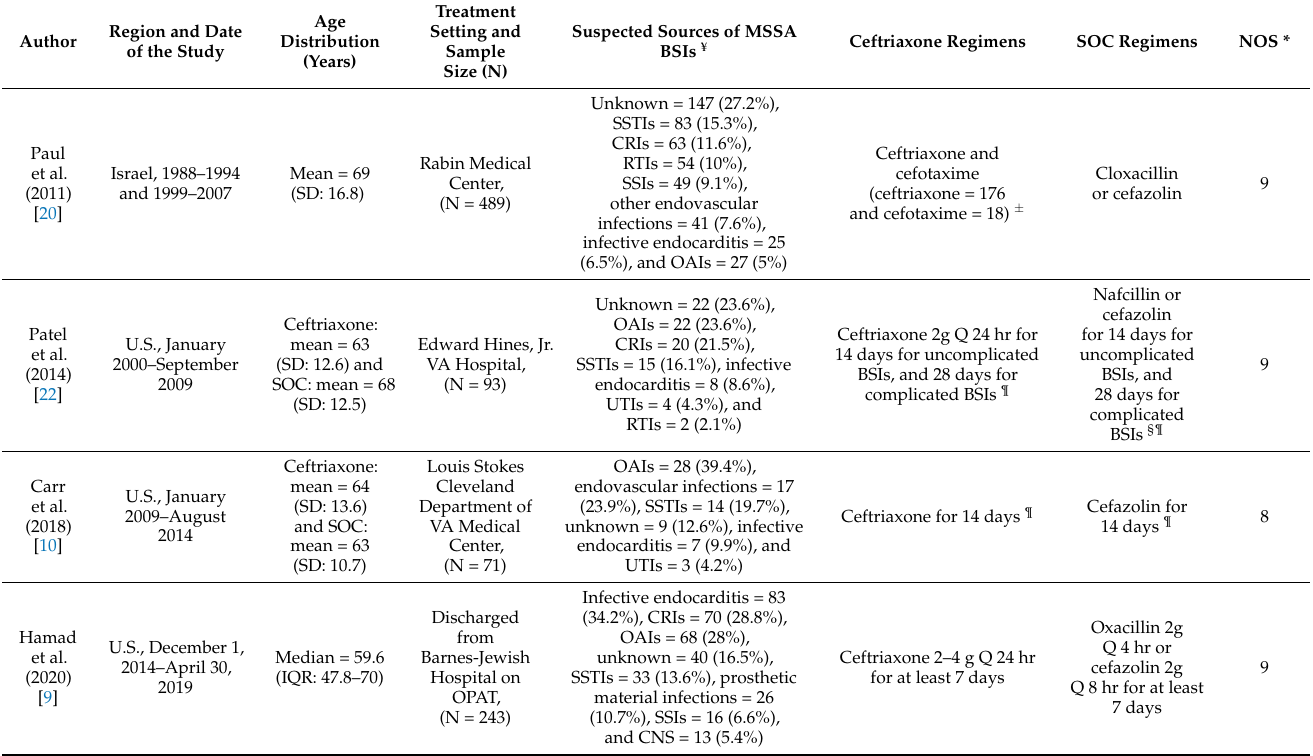
Table 1. Characteristics of the included